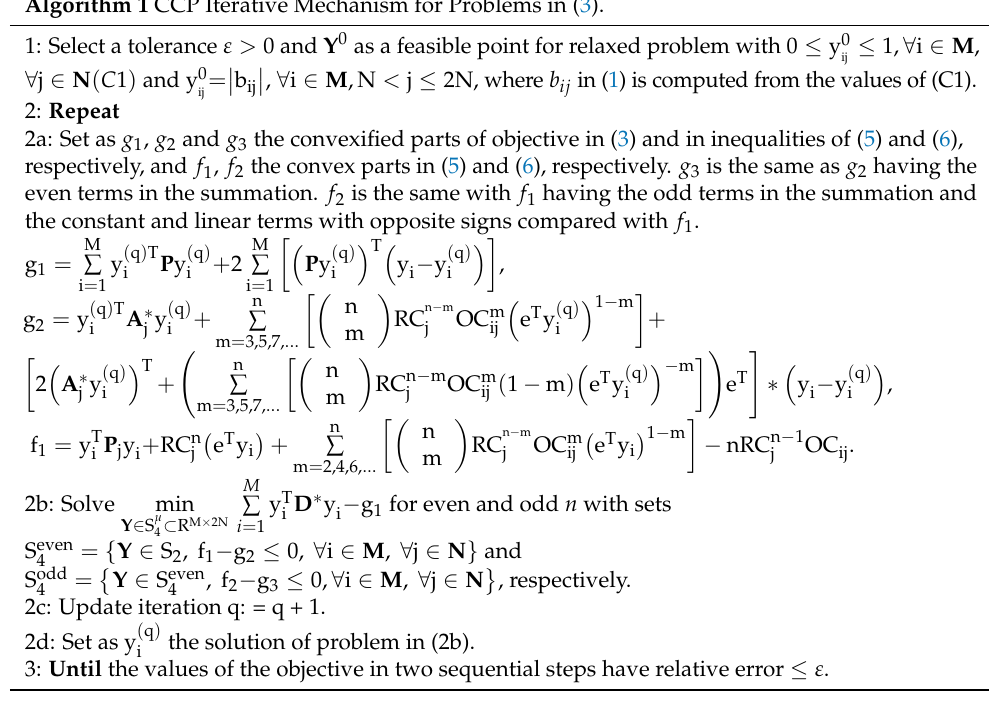
Algorithm 1 CCP Iterative Mechanism for Problems in